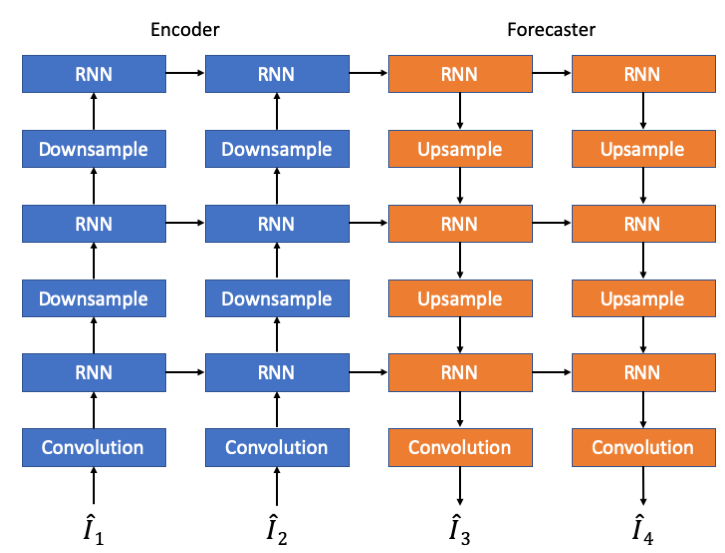
Figure 3. Schema of the deep learning architecture adopted by TrajGRU, in a configuration with two input and two output